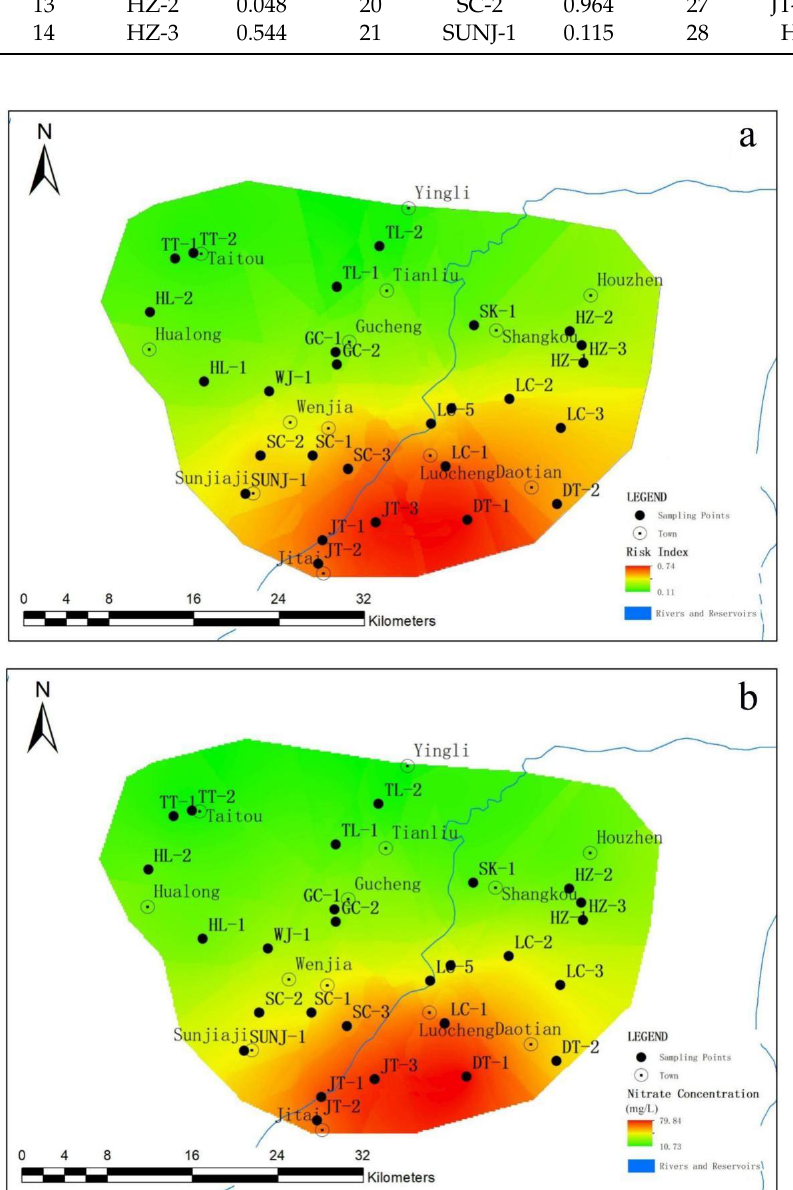
Figure 4. Nitrate pollution risk index distribution and nitrate content distribution. ( a ) is the distri- bution map of nitrate pollution risk index in the study area, ( b ) is the distribution map of nitrate in shallow